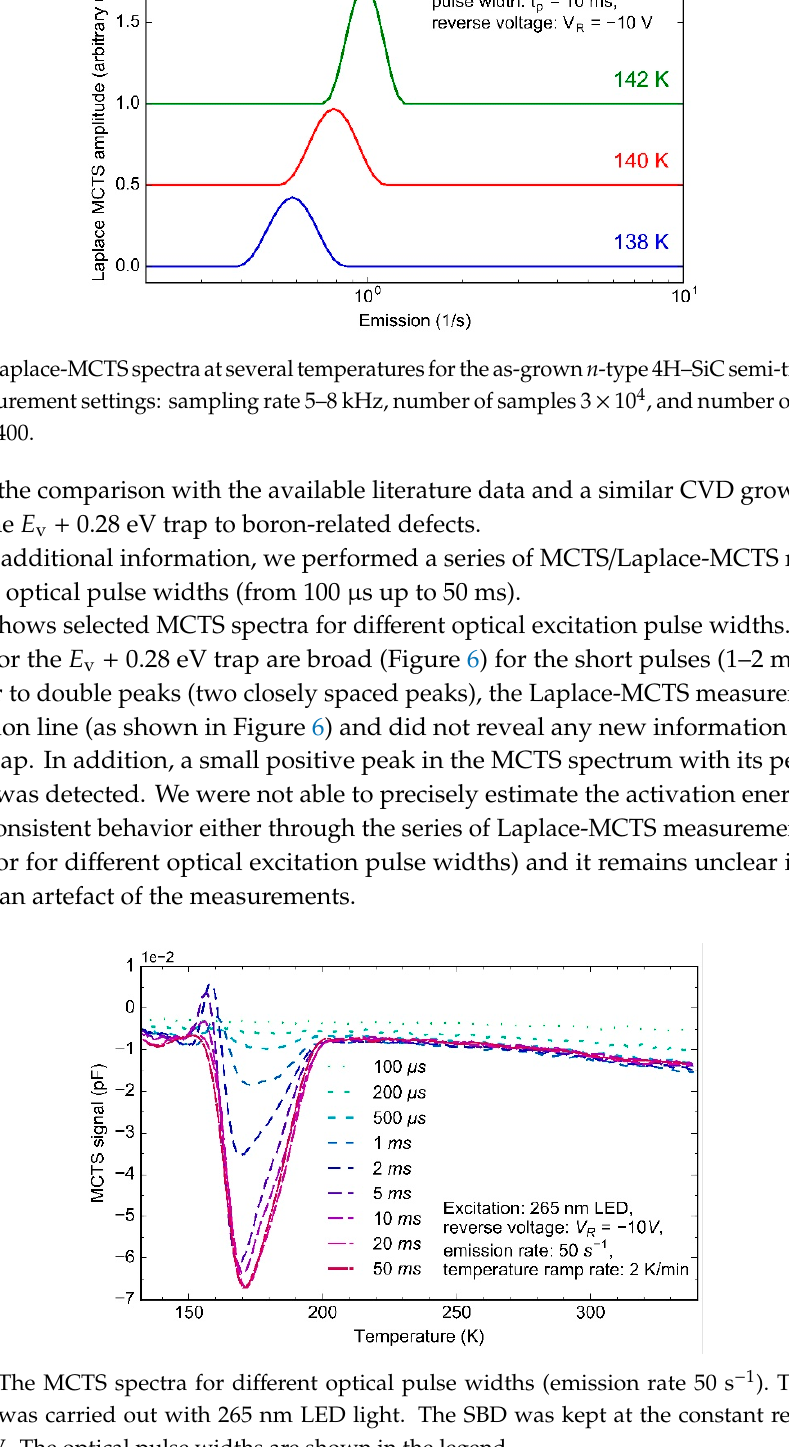
Figure 4. Arrhenius graph for the activation energy for hole emission obtained from MCTS measurements for the as-grown n -type 4H–SiC semi-transparent SBD.